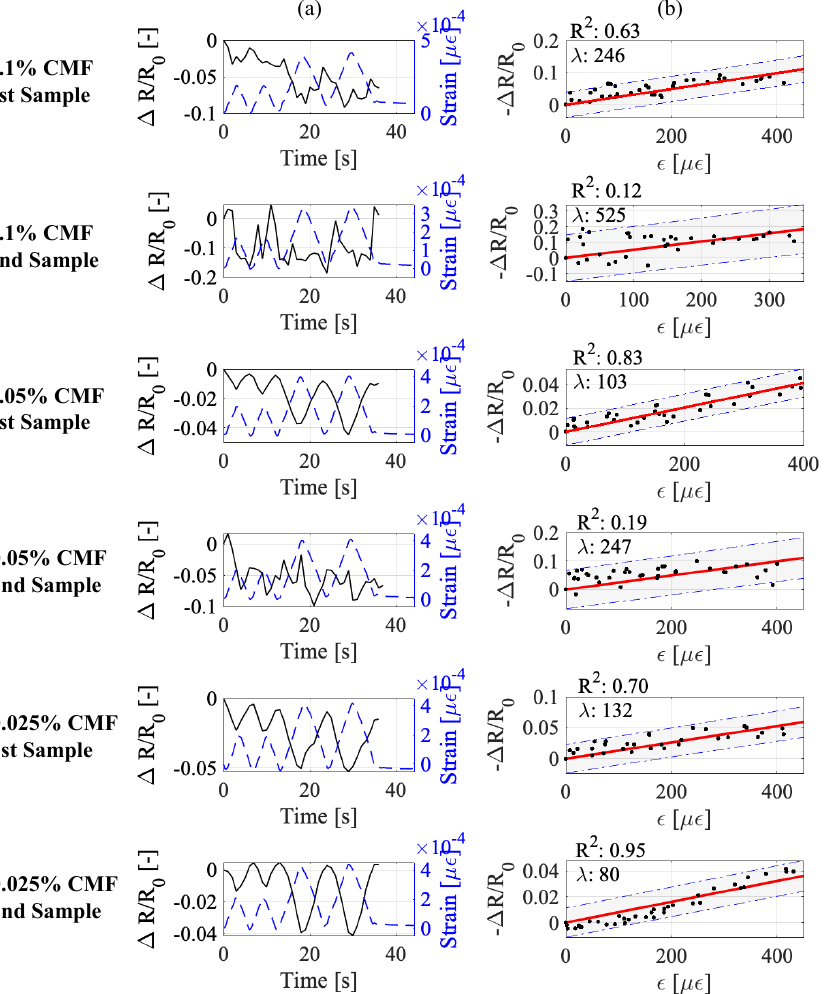
Figure 6. The measured signals from the set of beam samples when considering whole sensor volume as the sensor: ( a ) the time histories of induced strain and the fractional change in sample resistance; ( b ) the linear models of strain sensing established based on time